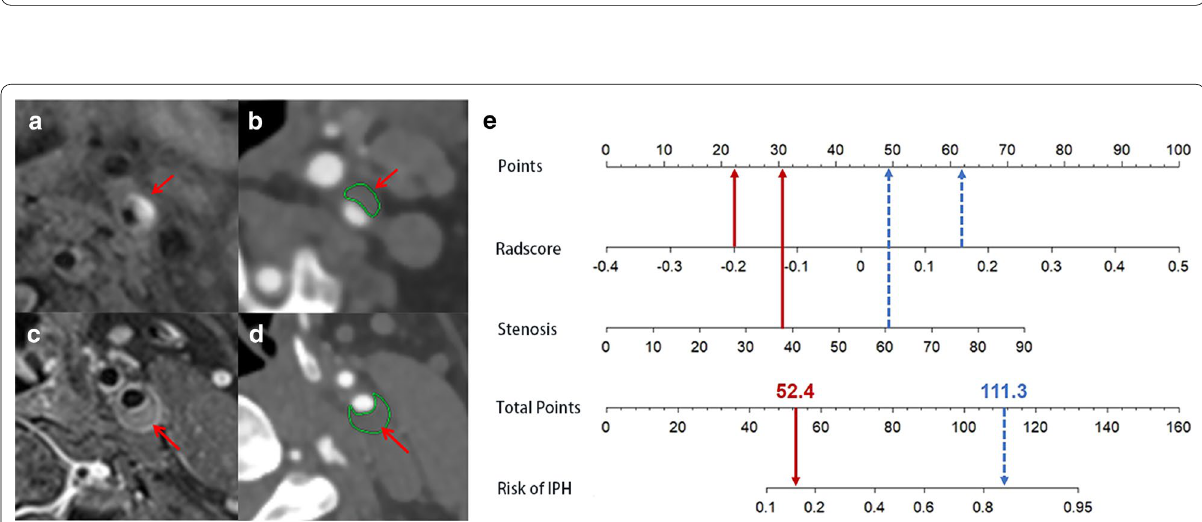
Fig. 4 Receiver operating characteristic curves of the clinical factor model, the radiomics signature, and radiomics nomogram in the training ( a ) and external test ( b ) sets, respectively